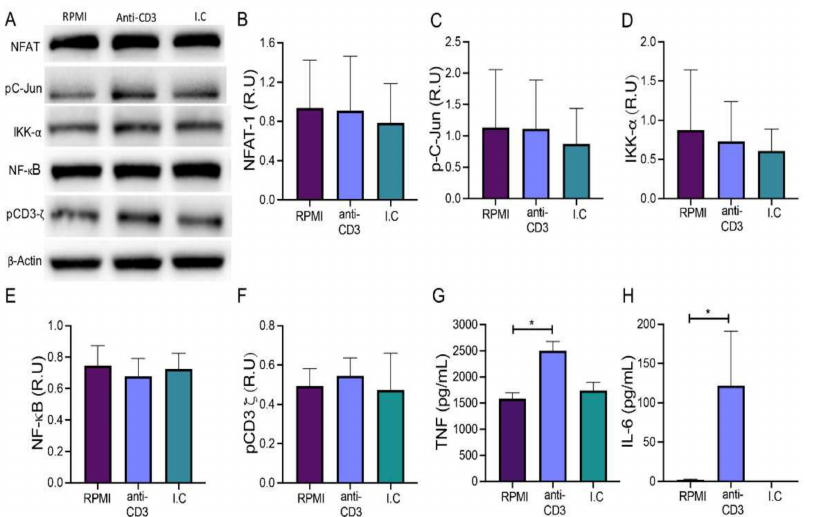
Figure 4. The anti-CD3 monoclonal antibody does not induce activation in total RAW cells. ( A ) Immunoblot evaluation of proteins involved in the CD3 signaling pathway; NFAT, phospho- rylated C-Jun (pC-Jun), IKK- α , NF- κ B and phosphorylated CD3- ζ chain (pCD3- ζ ), β -Tubulin as loading control in lysates of RAW cells cultured for 24 h under the following conditions: RPMI (control), anti-CD3 (stimulus), and isotype control. Relative units (R.U) of NFAT, pC-Jun, IKK- α , NF- κ B, and pCD3- ζ in RAW cell lysates (( B – F ), respectively). Levels of TNF and IL-6 were mea- sured in supernatants collected from total RAW cells by ELISA sandwich assay (( G , H ), respectively). n = 5 independent experiments (immunoblot) and n = 5 independent experiments performed in triplicate (ELISA). Bars represent the mean value ± SD ( B – F ) or the mean of means ± SEM ( G , H ). Kruskal–Wallis and corrected for the Dunn test were used for immunoblot data and one-way ANOVA followed by Bonferroni test for ELISA. * p <